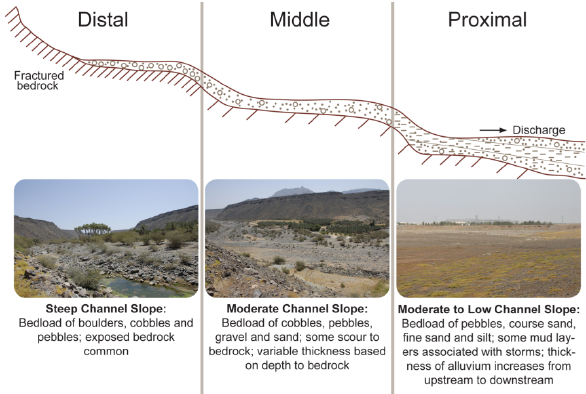
Figure 2. Characteristics of wadi channels in western Saudi Arabia showing the distal, middle, and lower segments (from Missimer et al. [12]).